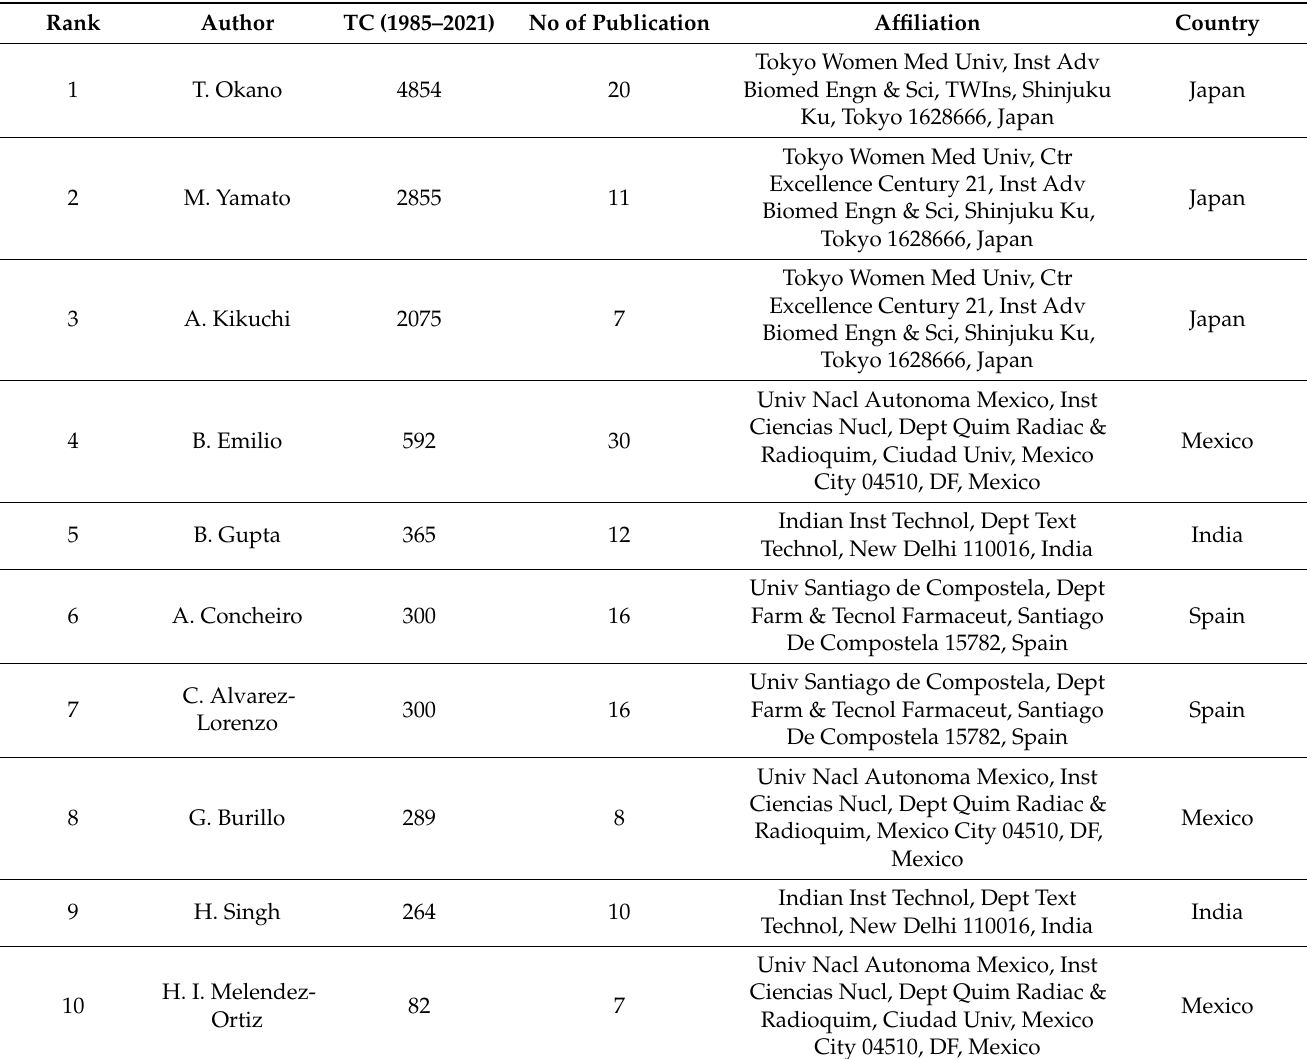
Table 5. Top 10 influential researchers (based on TC) on FPBMs prepared by